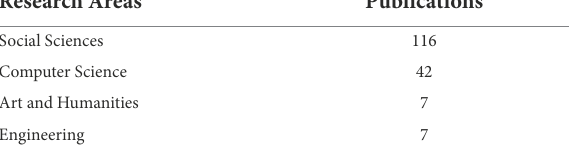
TABLE 8 Research